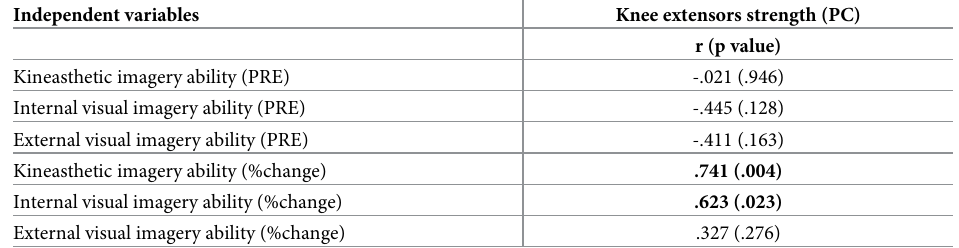
Table 4. Correlations between maximal isometric knee extension strength and motor imagery ability during PRE and for calculating the % of change.